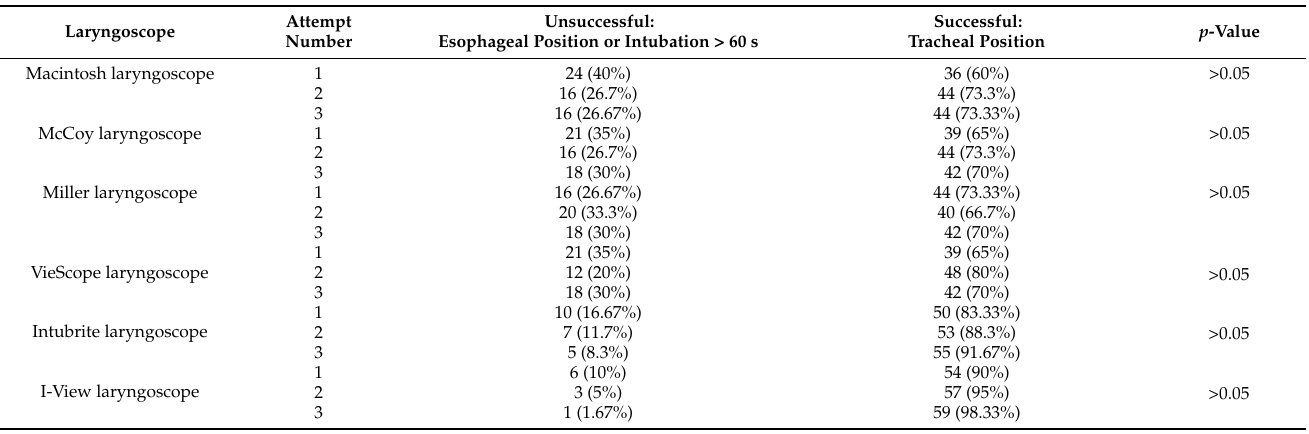
Table 1. The comparison of success rates of intubation based on laryngoscopes and attempts. p -value of comparison of successful and unsuccessful attempts for each studied